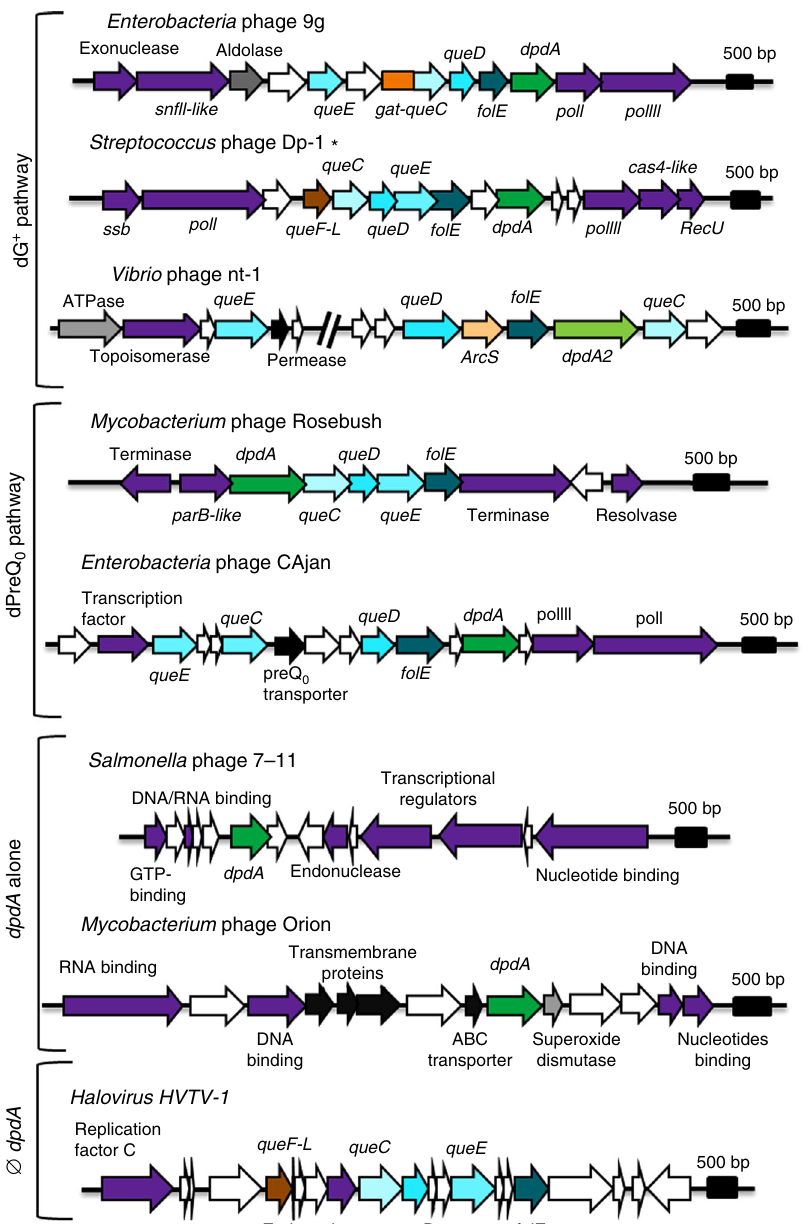
Fig. 3 Genomic context of the dpdA and dG + /preQ 0 biosynthesis pathway genes. Enterobacteria phage 9g, Streptococcus phage Dp-1, Vibrio phage nt-1, Mycobacterium phage Rosebush, Escherichia phage CAjan, Salmonella phage 7 – 11, Mycobacterium phage Orion, and Halovirus HVTV-1 are presented. The genes are colored by functions: green is DpdA, shades of blue are the biosynthetic pathway of preQ 0 , shade of oranges are the genes coding for aminotransferases that synthetize G + from preQ 0 , red is QueF. In purple are the proteins involved in DNA metabolism; in black, the transmembrane proteins; in gray, all other known functions; and in white, genes coding for unknown functions. Asterisk ( * ): Note that we grouped Streptococcus phage